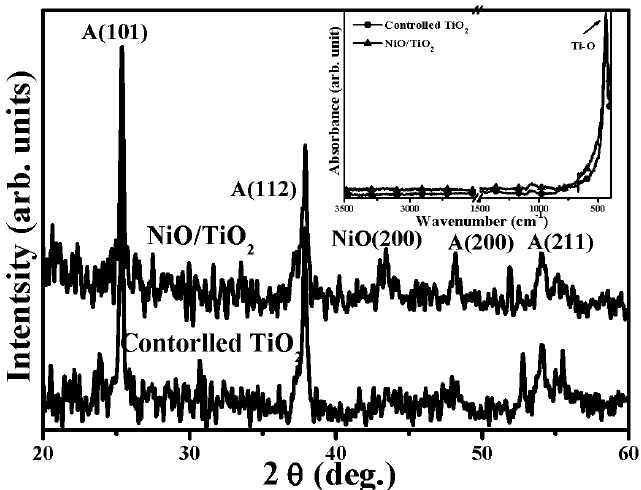
Figure 5. XRD patterns of the controlled TiO 2 film and the 550 °C-annealed NiO/TiO